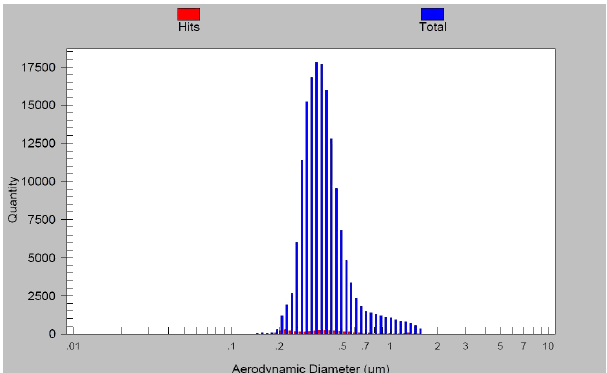
Figure 9. ATOFMS-measured aerodynamic size distribution of par- ticles that were “sized” (blue bars) and subsequently “hit” (red bars) by the ionization laser, i.e., particles that produced a mass spectrum and were chemically analyzed. All particles measured at the IF sta- tion are